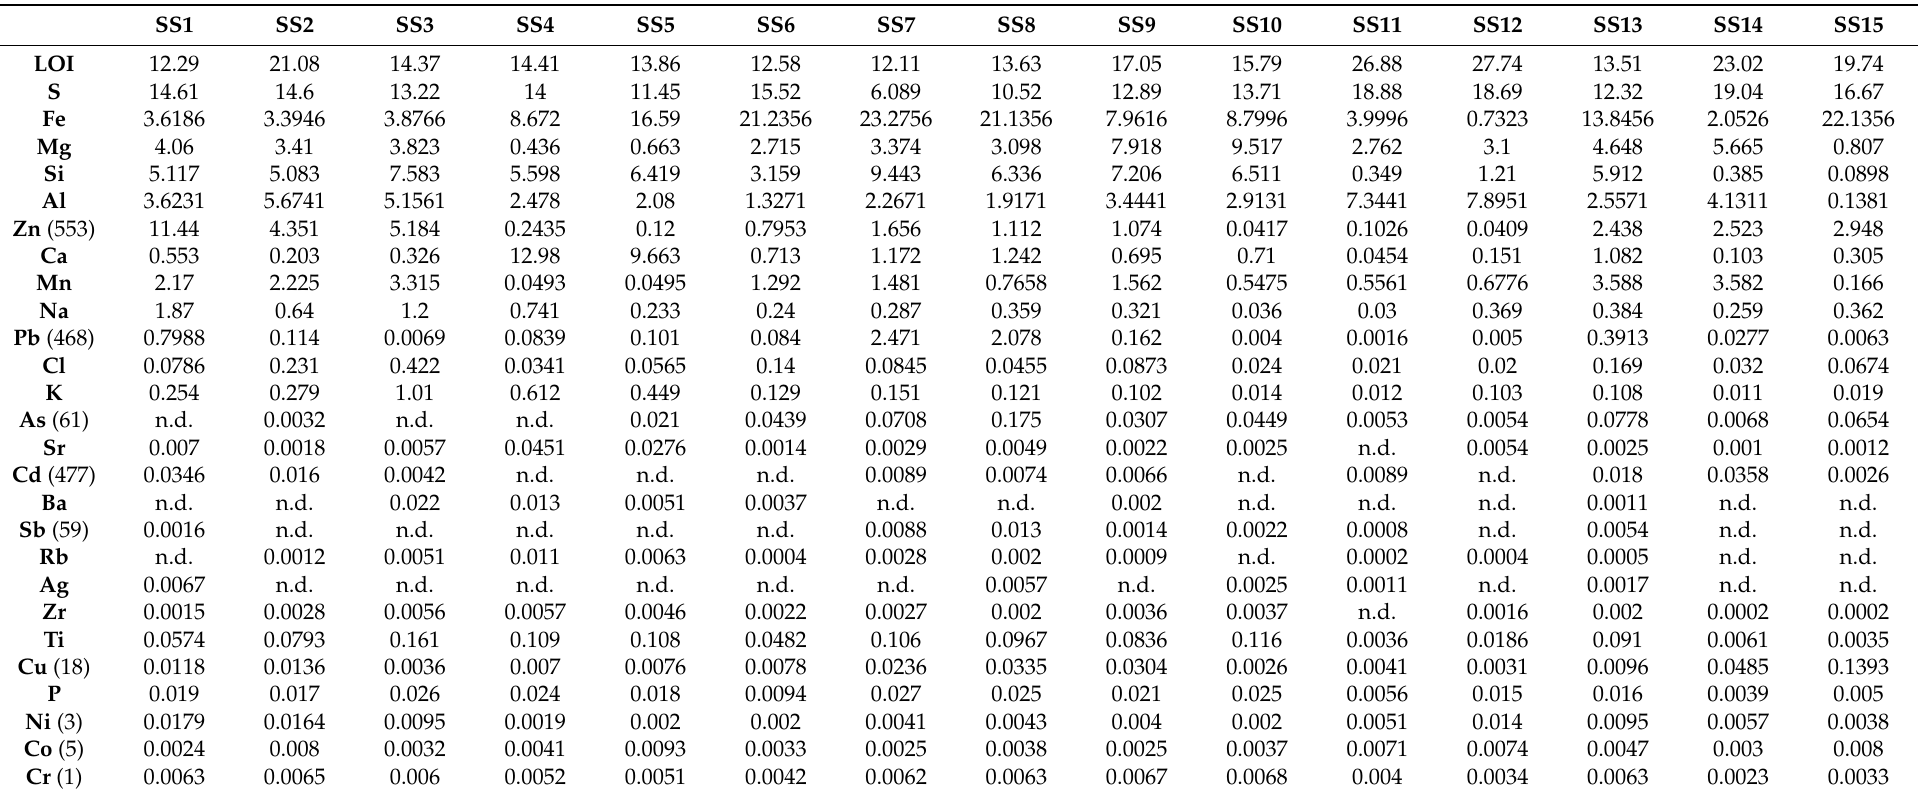
Table 2. Ignition weight loss (LOI) and geochemical composition in decreasing order of element concentration of the salt efflorescences determined by TG–MS